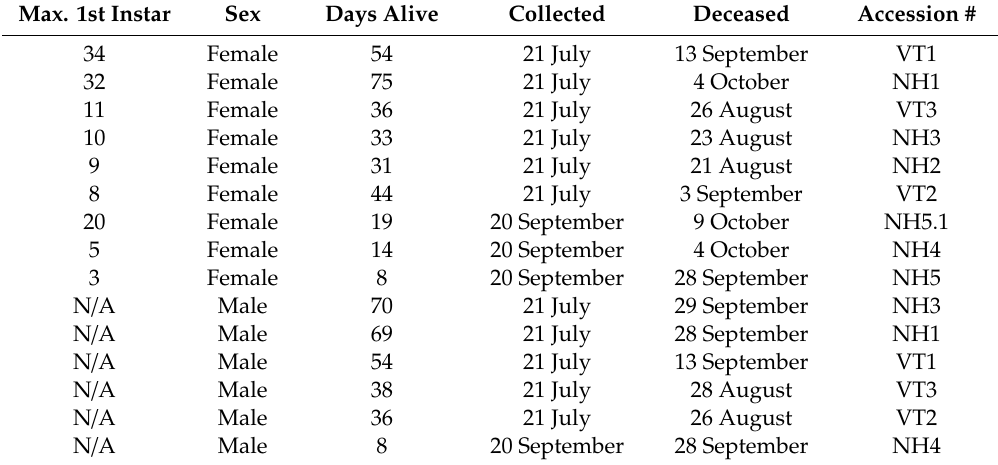
Table 2. Survival and estimated fecundity of cobblestone tiger beetle adults used for laboratory rearing of larvae, collected in summer / fall of